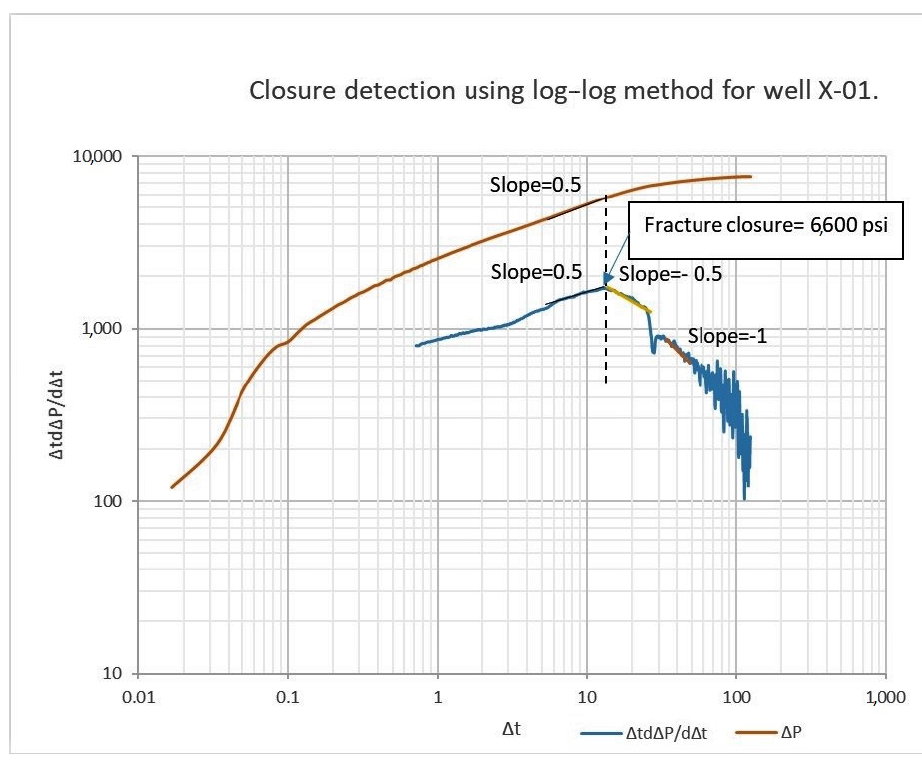
Figure 23. Closure detection using the log–log method for well